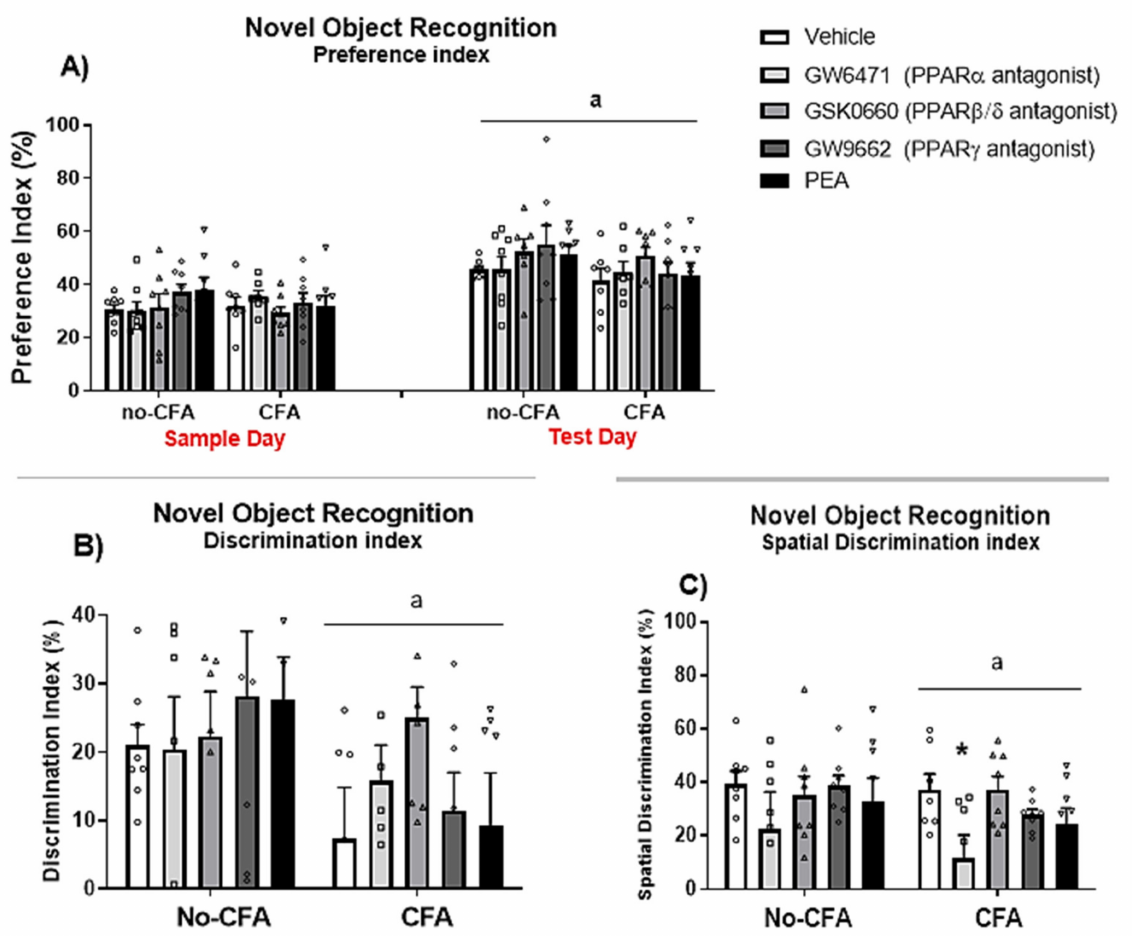
Figure 7. Effects of systemic administration of vehicle, selective PPAR α (GW6471), PPAR β / δ (GSK0660) and PPAR γ (GW9662) antagonists, and PEA on behaviour in the NOR test in CFA-injected (CFA) and control (No-CFA) rats. Two-way ANOVA revealed an effect of day ( a p < 0.001) on the percentage of time spent exploring the novel object compared to object 3 (i.e., preference index = TObject3 or Novel Object/(TObject 1 + TObject 2/2) + TObject3 or Novel Object multiplied by 100; ( A ). CFA injection ( a p < 0.05; ( B , C )) was also shown to have an effect on the discrimination index (Discrimination index = TNovel object/(TObject1 + TObject2/2) + TN multiplied by 100) and on the spatial discrimination index (Spatial discrimination index = TNovel object-TObject3/TNovel object + TObject3 multiplied by 100). GW6471 significantly reduced the spatial discrimination index compared to vehicle-treated CFA rats (* p < 0.05, vs. CFA-Vehicle; ( C )). Data are expressed as means ± SEM ( n = 7–8 rats per group). The symbols represent each individual data